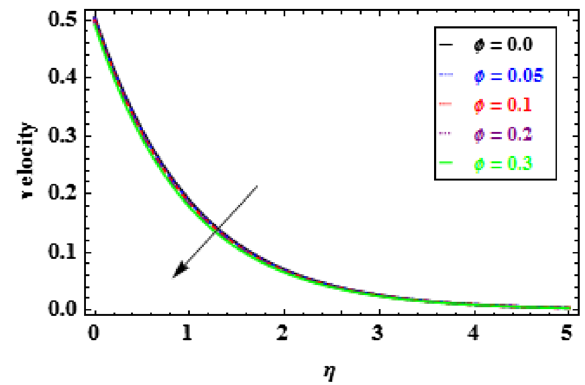
Figure 8. Inspiration of φ on velocity.